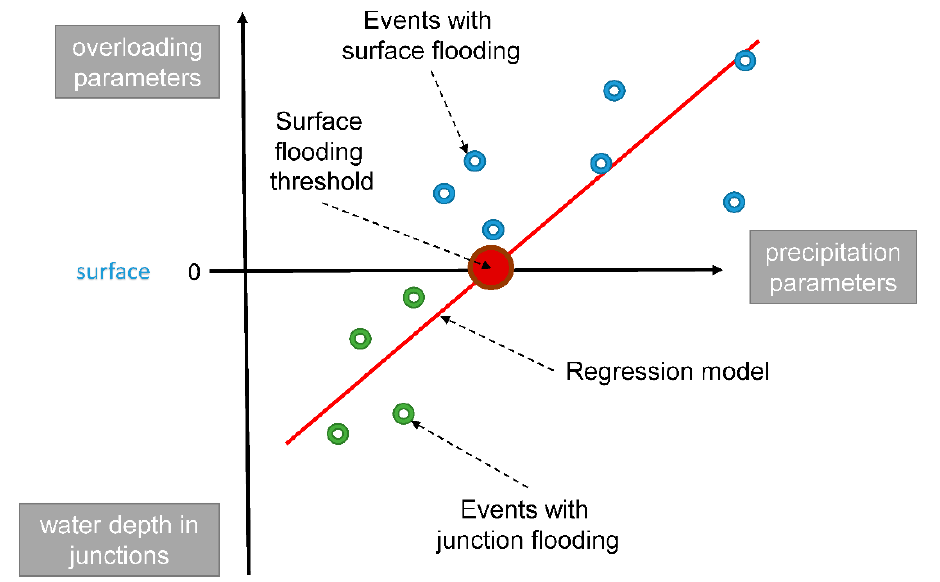
Figure 6. Overview of the study project data workflow.